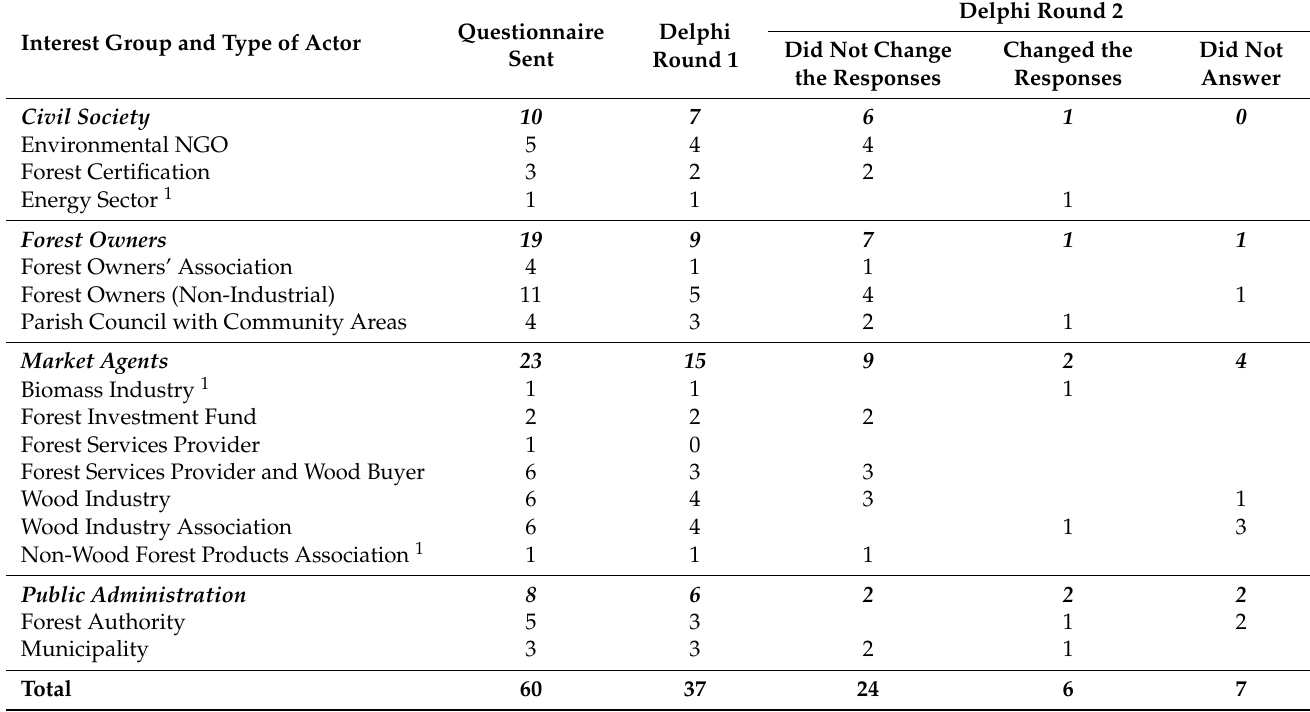
Table 2. Identification of the actors to whom the Delphi questionnaire was sent and those who answered in both rounds, by interest